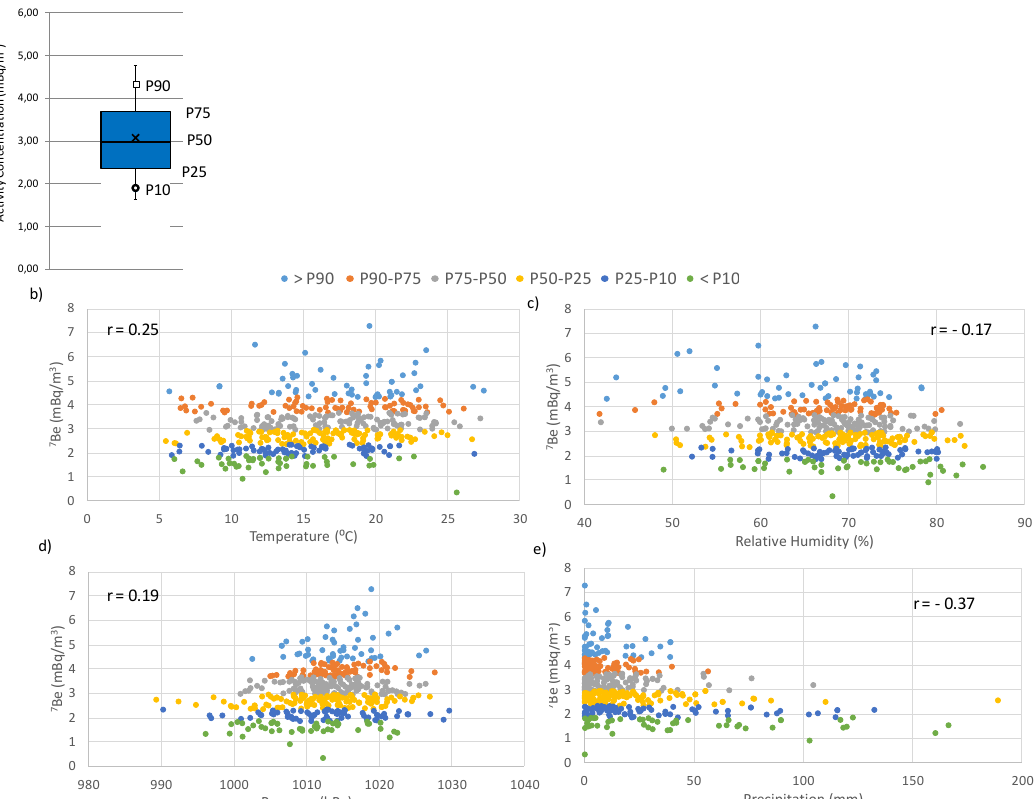
Figure 8. ( a ) Box-and-whisker plot of 7 Be activity concentrations from January 2009 to December 2018 at Bilbao sampling station, and the relationship between 7 Be concentration and meteorological parameters, ( b ) temperature, ( c ) relative humidity, ( d ) pressure, and ( e ) precipitation. In the center of the box denotes the 50% (P50), and the bottom and top of the box correspond to the 25% (P25) and 75% (P75) values, respectively. The square indicates the P90 and the circle the P10 values, while the extremes of the box represent the P95 and P5 values. The black cross is the average value.